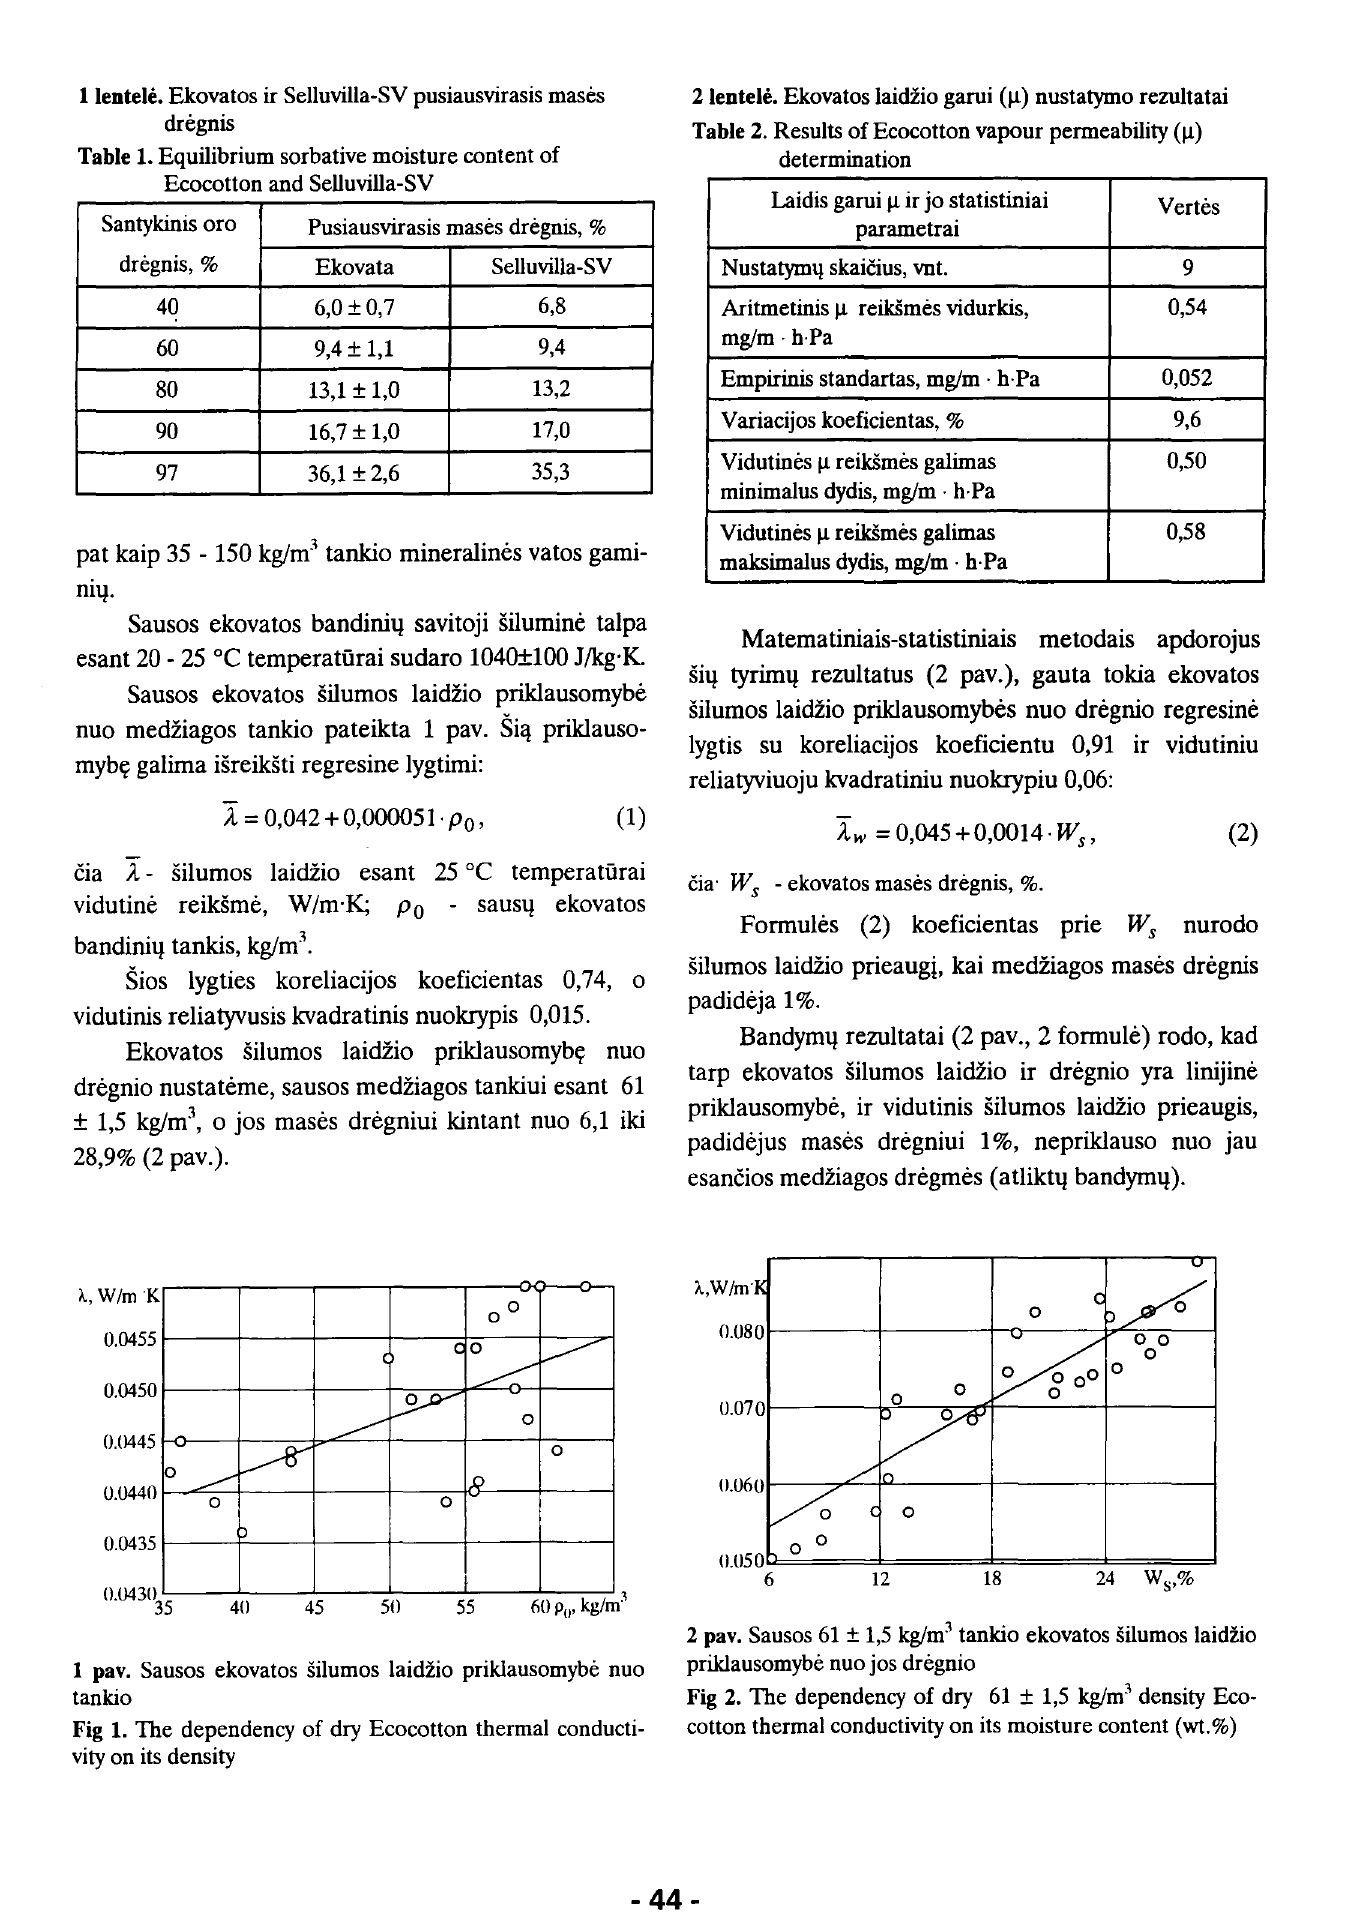
Table 2. Results of Ecocotton vapour permeability (J.L) determination